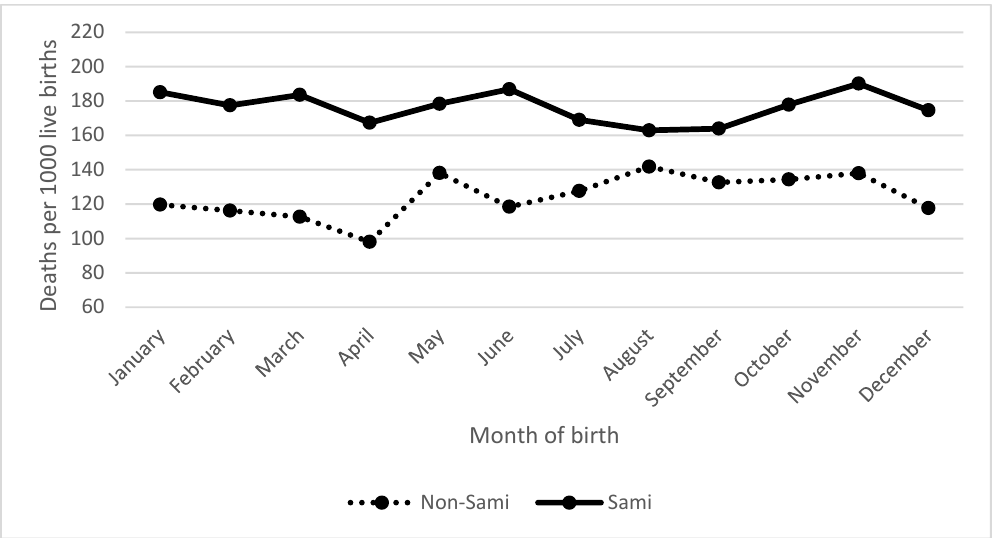
Figure 2. Monthly variation in infant mortality rate (q0–11) by month of birth, Sami and non-Sami populations, 1800–1899. Source: Demographic Data Base, Umeå University.